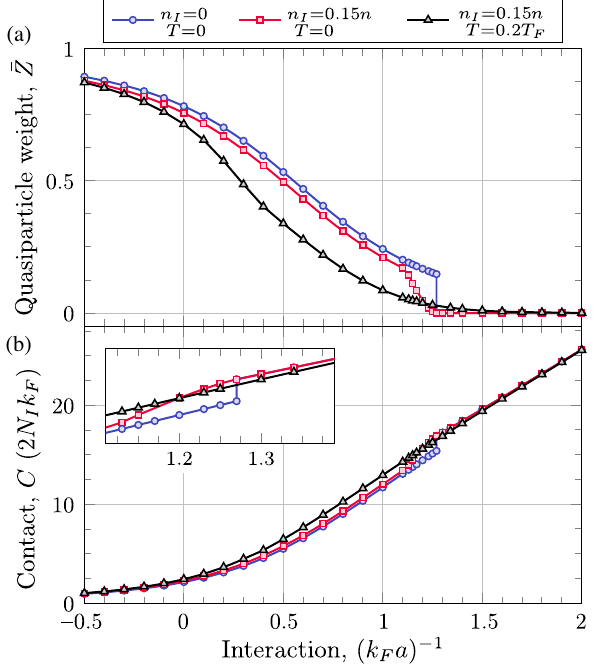
FIG. 8. Calculated quasiparticle weight and contact. The quasiparticle weight (a) and contact coefficient (b) are shown for different interaction strengths. In the single-impurity limit (blue), the transition between polaron and molecule at ð k F a Þ − 1 ≈ 1 . 27 leads to a sharp jump between the polaronic and molecular residues and contacts. As in Fig. 7, at T ¼ 0 and finite impurity density ( 0 . 15 n , red) the transition is smoothed, and eventually blurred at finite impurity density and temperature ( 0 . 2 T F , black). The inset in (b) shows a magnification around the transition